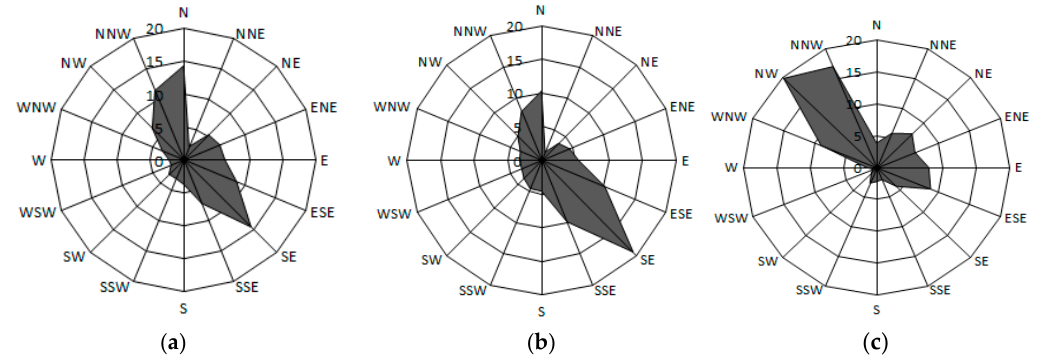
Figure 2. Plots showing the occurrence of wind direction during the study period (January 2005 to September 2011): ( a ) across the year; ( b ) in spring and summer; and ( c ) in fall and winter.